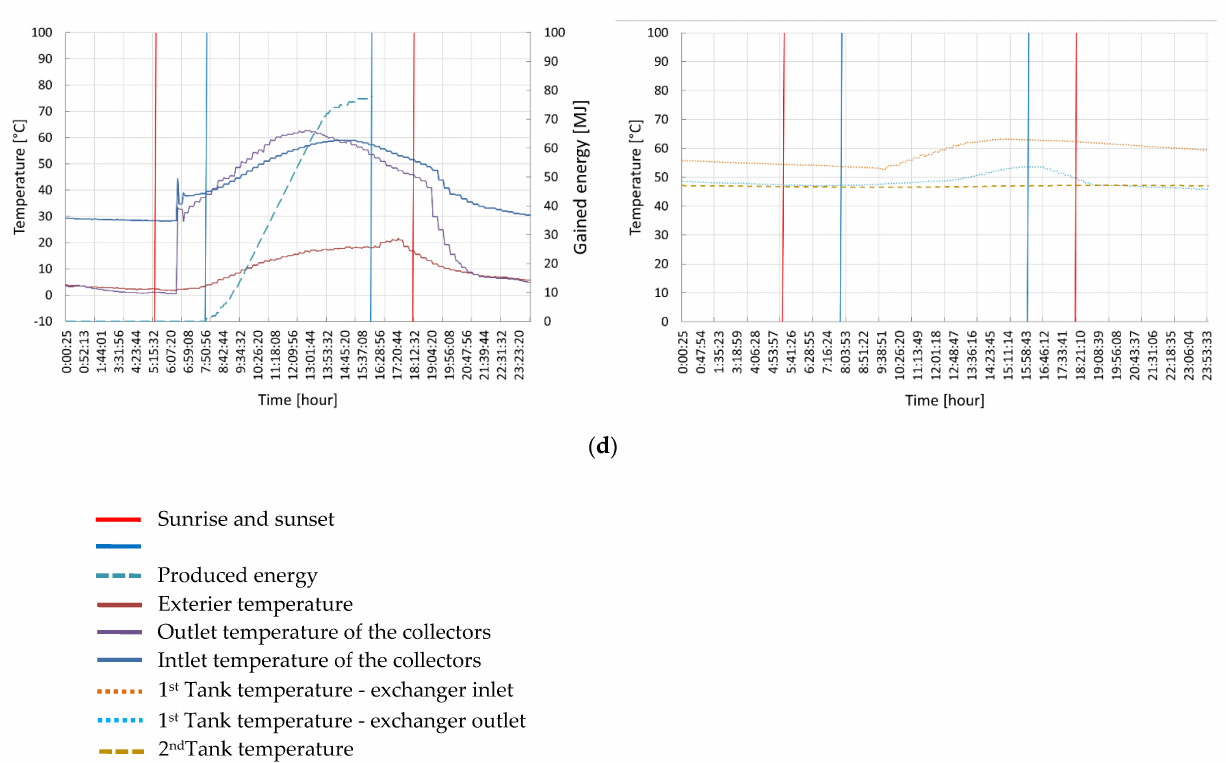
Figure 14. daily profiles of monitored data ( a ) 21 March 2019 and ( b ) 2 April 2019 for a system with active rotation, ( c ) 29 March 2019 and ( d ) 30 March 2019 for a static system without rotation of thermal